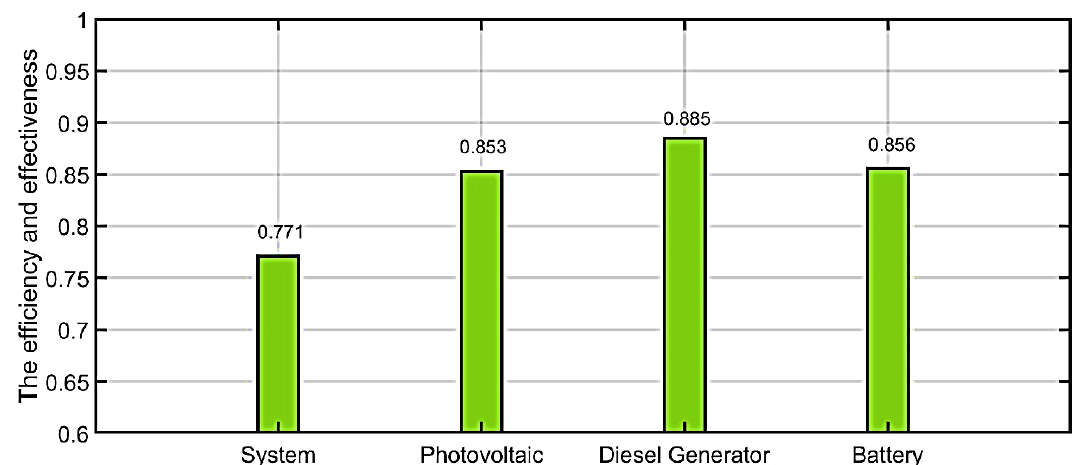
Figure 15. The efficiency and effectiveness by using proposed method.